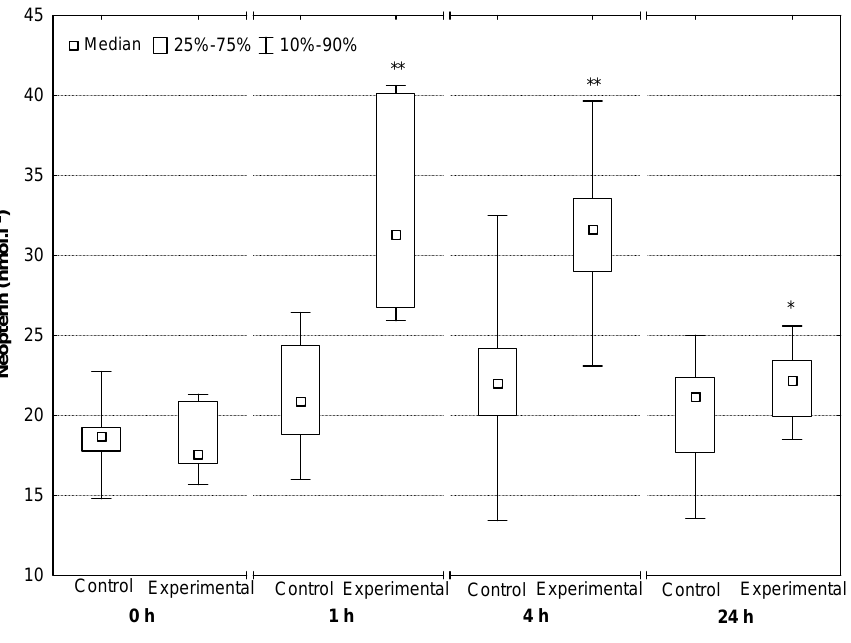
Figure 1. Serum neopterin concentrations in piglets which received no Fe 3+ -dextran (control group) and piglets administered Fe 3+ -dextran (experimental group; * p < 0.05, ** p < 0.01).